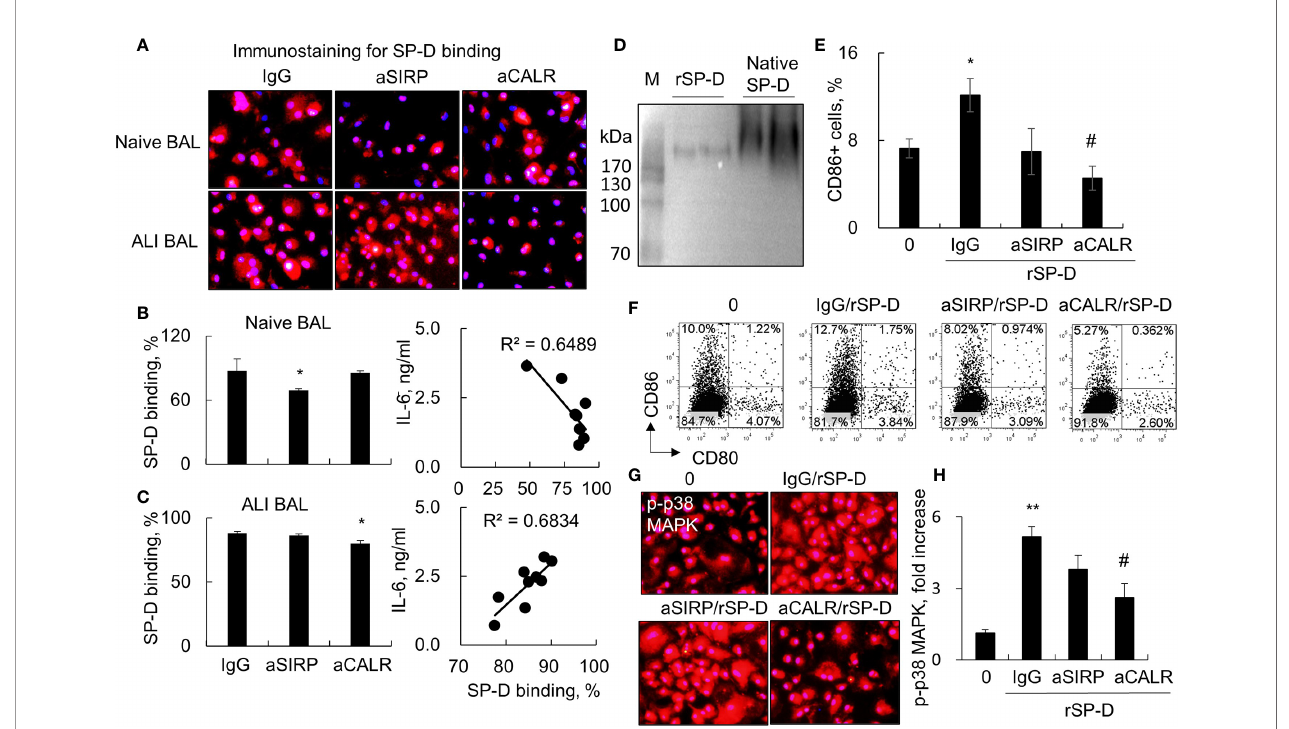
FIGURE 3 | Blocking calreticulin activity predominantly reduced binding and activation of macrophages by acute lung injury (ALI) mouse-derived surfactant protein D (SP-D). (A) Immunostaining analysis for bronchoalveolar lavage (BAL)-derived endogenous SP-D binding on macrophages pretreated with anti-SIRP (aSIRP)-alpha and anti-calreticulin (aCALR). RAW264.7 cells were treated with naive and ALI mouse-derived BAL (1:3 dilution) for 24 h. The SIRP-alpha and calreticulin activities were pre-blocked with 2 µg/ml aSIRP or aCALR (Abcam, CA, USA) for 1 h. SP-D binding was detected by incubation with mouse anti-SP-D antibody (dilution 1:250) and followed by Cy3-conjugated anti-mouse immunoglobulin G (IgG) (dilution 1:1,000). Red indicates positive staining. Representative photograph with magni fi cation ×200. (B, C) Quantitative analysis of SP-D binding of naive and ALI BAL by fl ow cytometry analysis and correlation with interleukin (IL)-6 expression. Data are presented as mean ± SE. n = 3, *p < 0.05 vs. IgG control. (D) Western blot analysis for recombinant murine SP-D (rSP-D) protein structure by native gel electrophoresis. Native SP-D is derived from BAL of naive mice. (E) Quantitative analysis for the expression of CD86 in treated RAW264.7 cells. *p < 0.05 vs. 0 group; # p < 0.05, ## p < 0.01 vs. IgG/rSP-D group. (F) Representative histogram for the expression of CD80 in the treated cells. (G, H) Immunostaining and quantitative analysis for the expression of p-p38 mitogen-activated protein kinase (MAPK) in treated cells. Representative photograph with magni fi cation ×200. Quantitative analysis of p-p38 MAPK positively stained cells by ImageJ software, and data are presented as mean increase of fl uorescence intensity over control ± SE, n = 3, **p < 0.01 vs . 0 group; # p < 0.05 vs . IgG/rSP-D